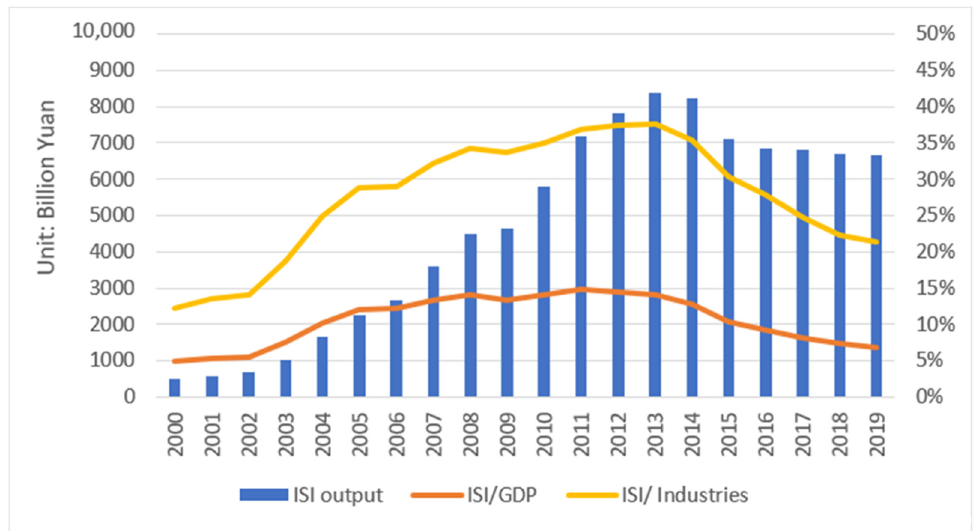
Figure 1. The output value of China’s ISI and its proportion in GDP and whole industries. Source: China Industry Statistical Yearbook, 2001–2020.